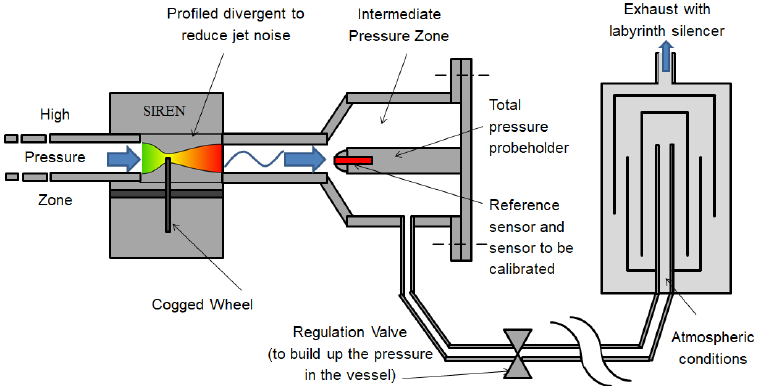
Figure 12. Schematic set-up for dynamic sensor calibration at various intermediate pressures and